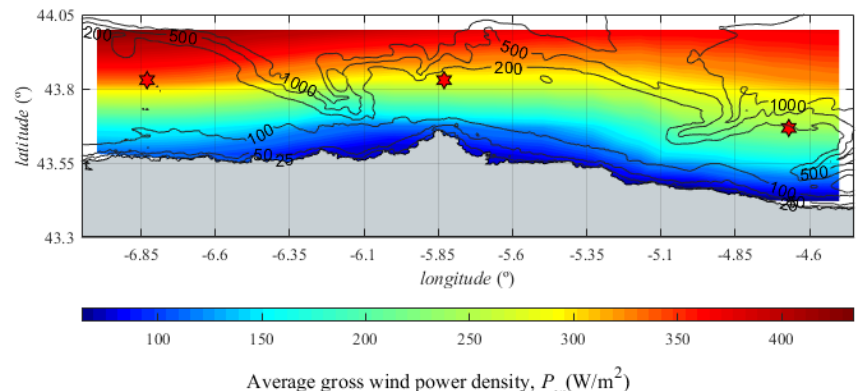
Figure 5. Average wind power density ( P w ) off Asturias. The three study sites (West, Centre and East) are marked with red stars. (Water depths in m).